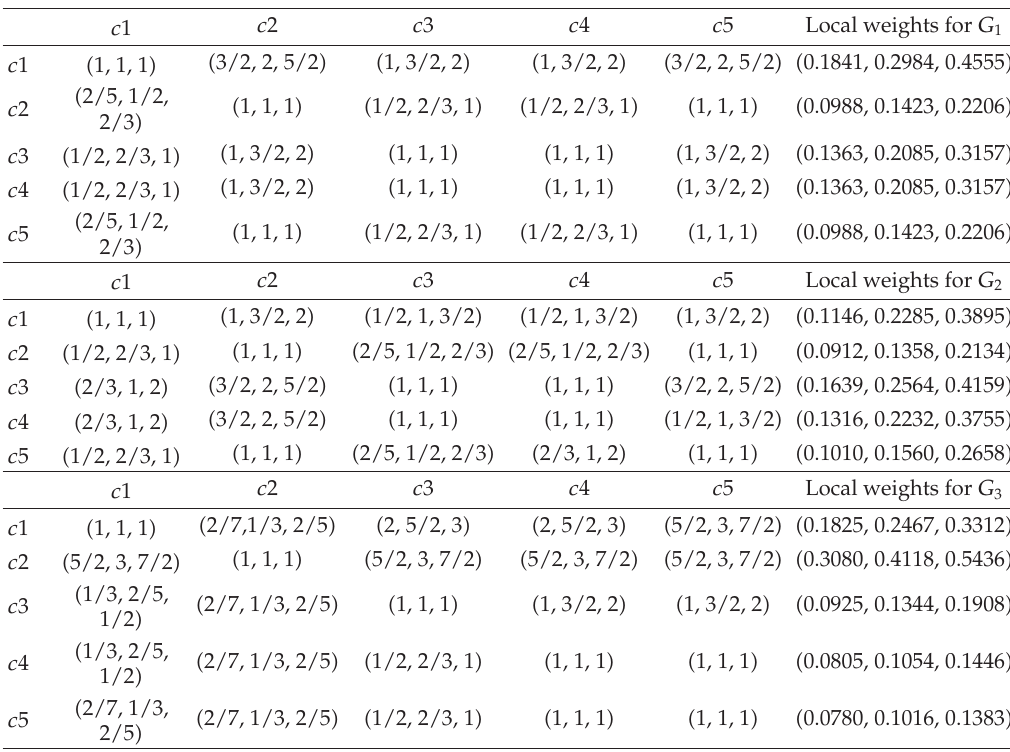
Table 5: Local weights and pairwise comparison matrix of subfactors belonging to PO.